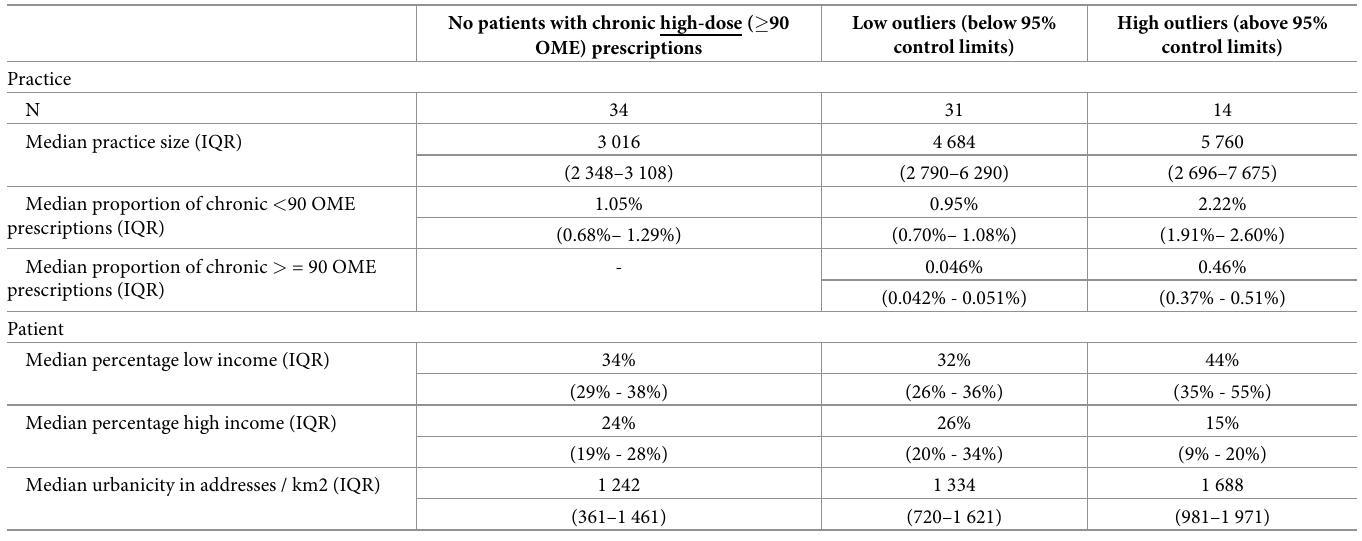
Table 4. Comparison of outlying practices in